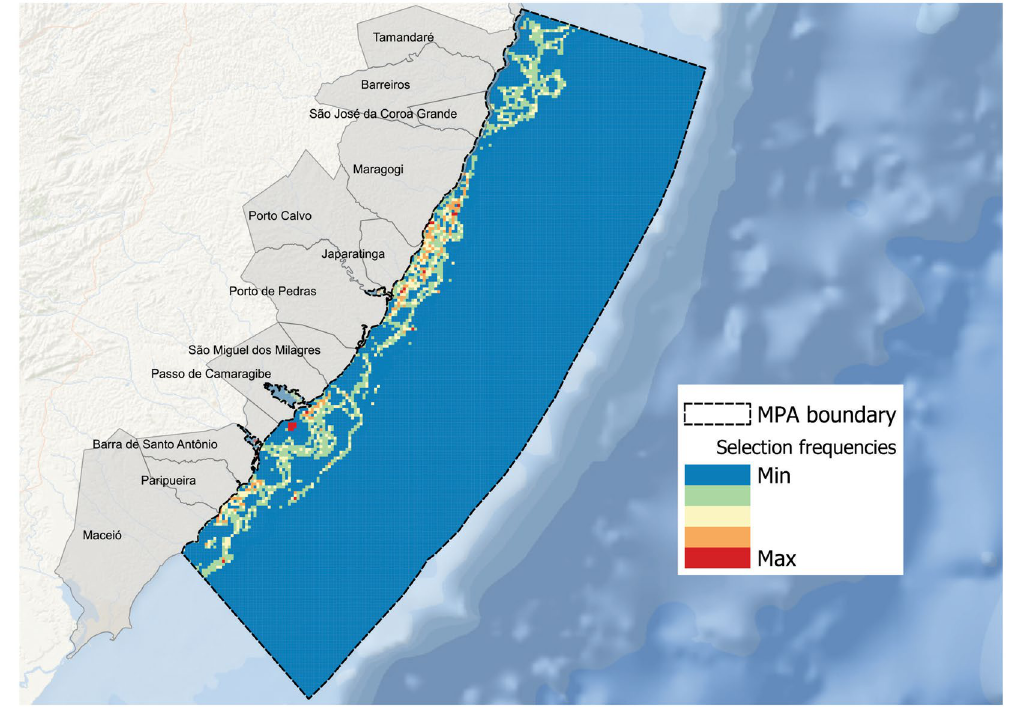
Figure 3. Selection frequency (0–100) output from Marxan, indicating more important areas (i.e., maximum selection frequency) for the conservation of the five parrotfish species. Figure elaborated by the authors using QGis 3.14.